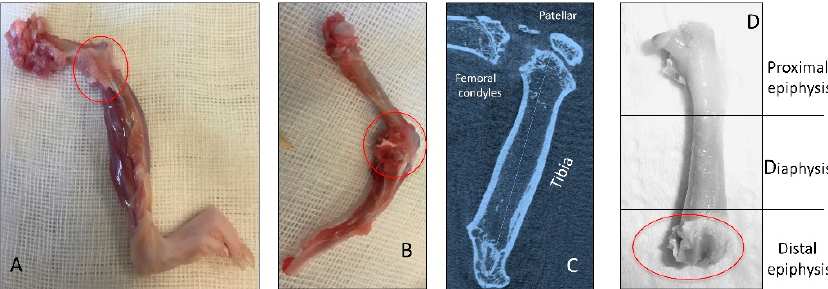
Figure 8. Representation of in vivo explanted knee join bones (red circles). ( A , B ) Knee OA bones joint after explantation, not cleaned of soft tissues; ( C ) X-ray microtomography imaging of the OA knee bones joint; ( D ) OA femur cleaned of soft tissues.